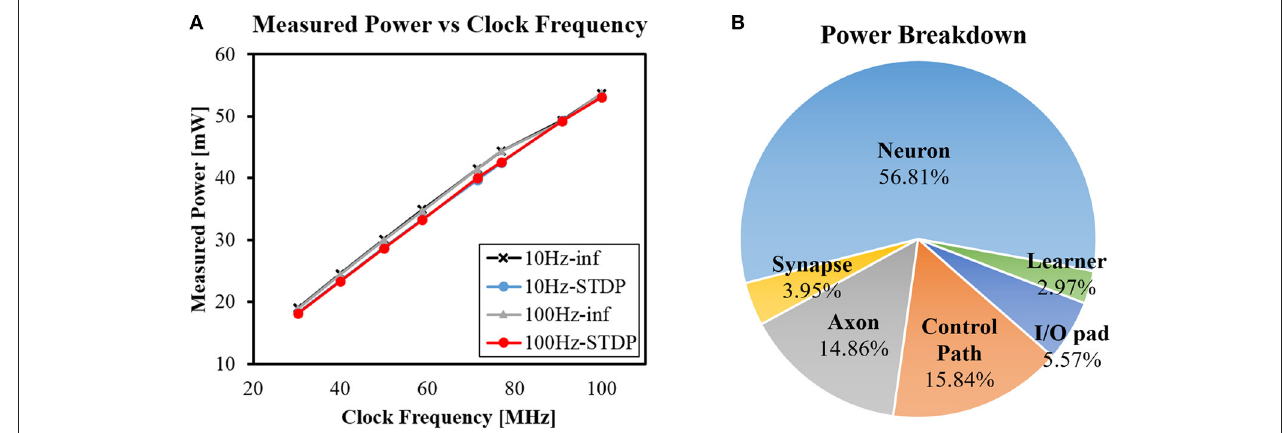
FIGURE 13 | (A) Measured power with different clock frequencies and (B) Power breakdown by functional module.